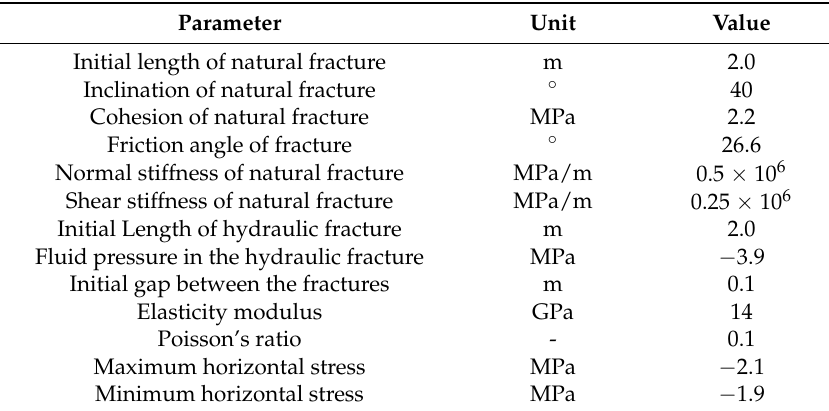
Figure 8. Geometry of hydraulic and inclined natural fractures. Table 1. The default value of the input